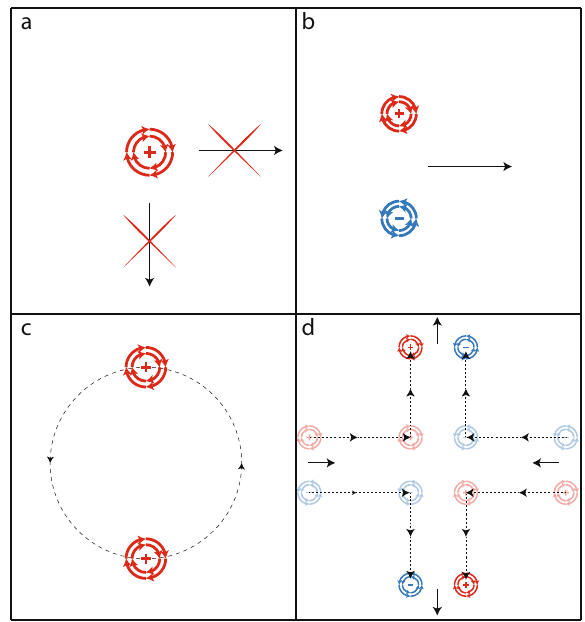
Fig. 1 Motion of point vortices. a An isolated vortex is immobile and corresponds to a fracton. b A neutral dipole moves perpendicular to its dipole moment — it is a “ lineon ” . c A charge 2-dipole moves around the center of vorticity. In fractonic context this motion is also possible, albeit never discussed: a pair of identical charges can rotate by constantly emitting dipoles that cancel. d Scattering of two dipoles of opposite dipole moments. Upon scattering the dipole makes a π /2